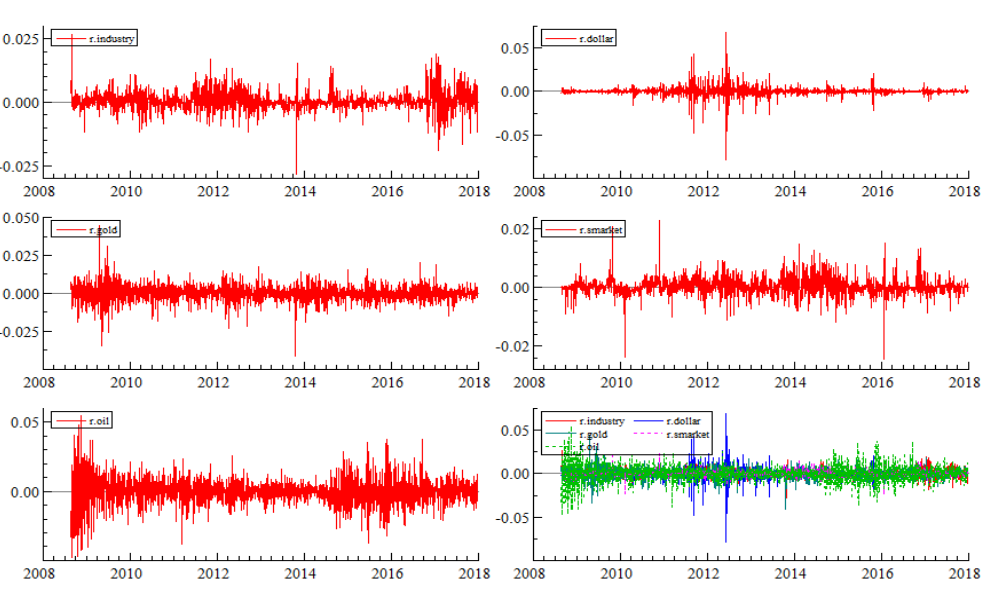
Figure 2 . The return of